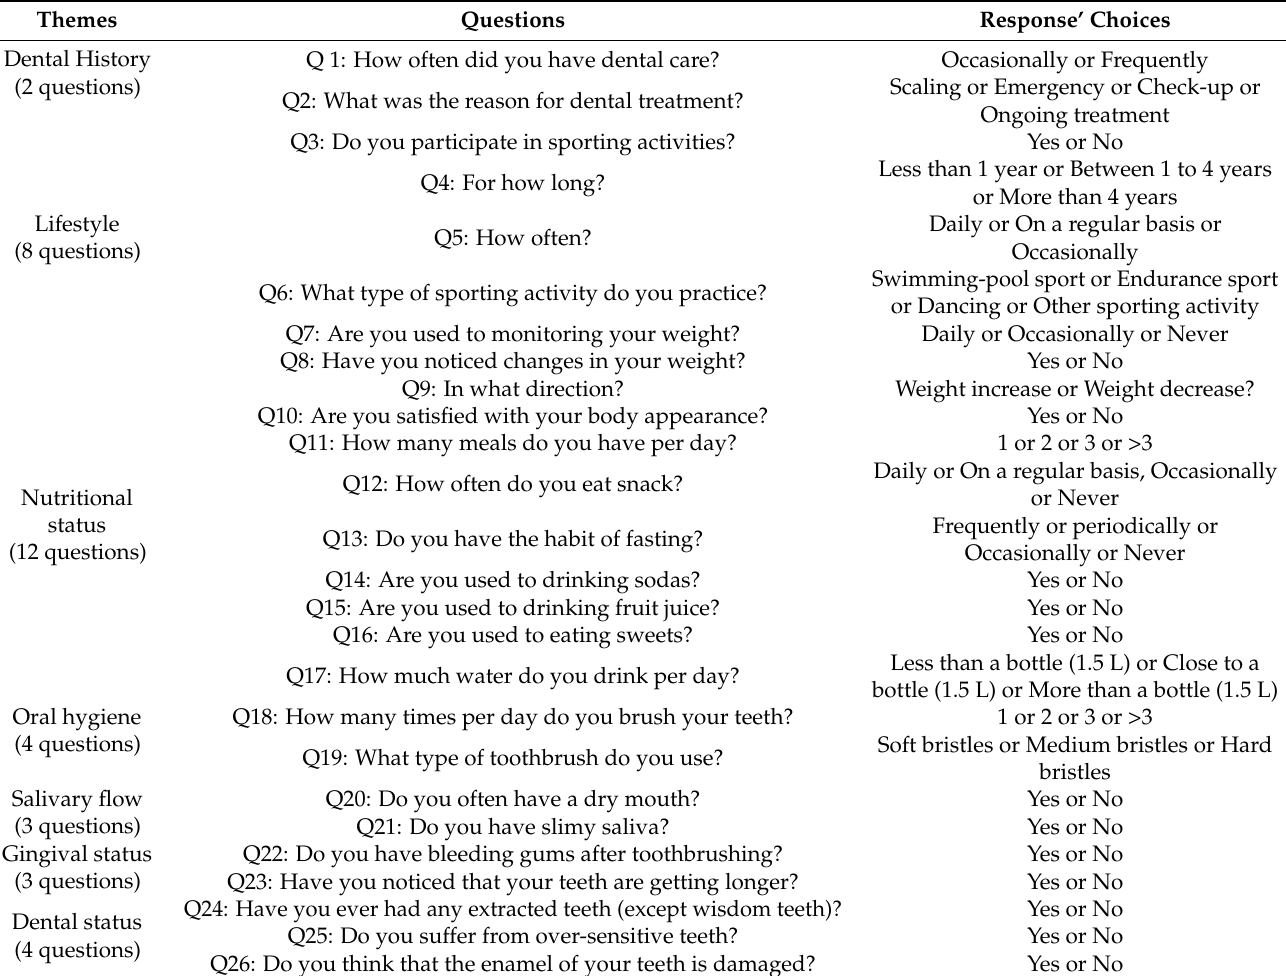
Table 1. The 26-item questionnaire for screening oral risk factors and symptoms in anorexia